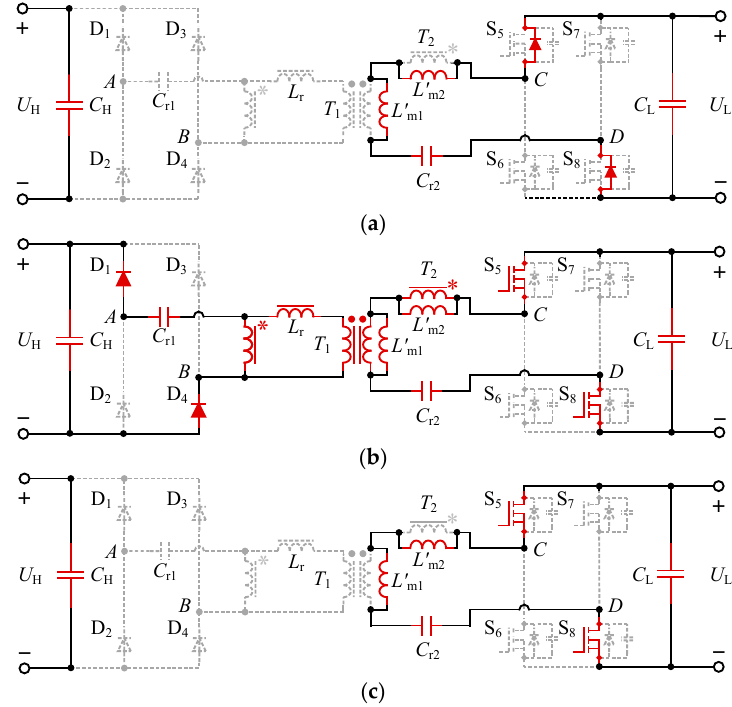
Figure 4. Equivalent circuits for each stage in backward mode: ( a ) Mode A; ( b ) Mode B; ( c ) Mode C.